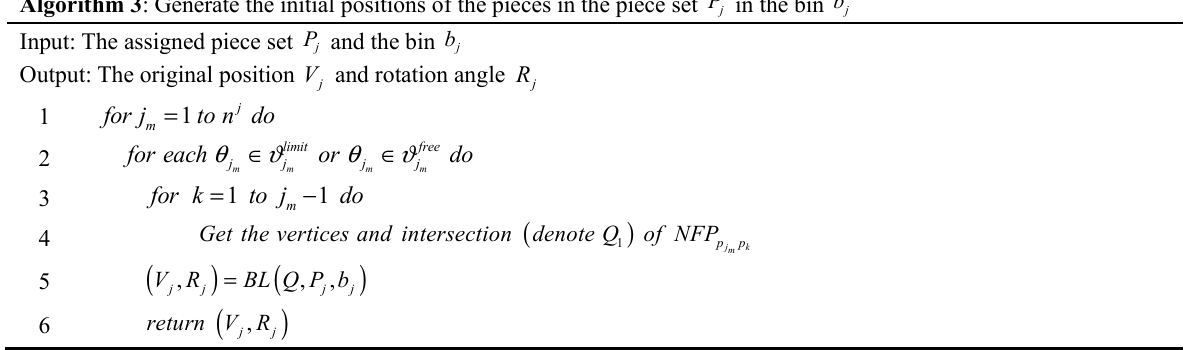
Algorithm 3 details the process of generating initial positions and angles for the pieces using the BL algorithm. Before this, the pieces are first arranged in a non-increasing order of area to obtain a corresponding order and then placed in the bin one NFP is used as j km p p candidate placement positions, and the leftmost bottom point with no overlap (discounting the overlap between the piece and the right edge of the bin) is chosen for each piece. P in the bin b Algorithm 3 : Generate the initial positions of the pieces in the piece set j j P and the bin Input: The assigned piece set j j